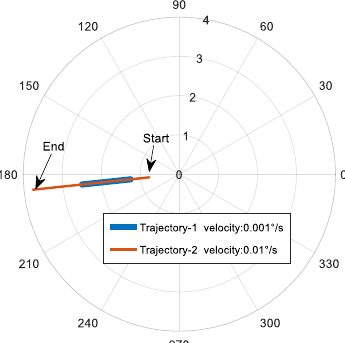
Figure 7. The trajectory of the target depicted in a polar coordinate system (the position of the target moves from right to left).